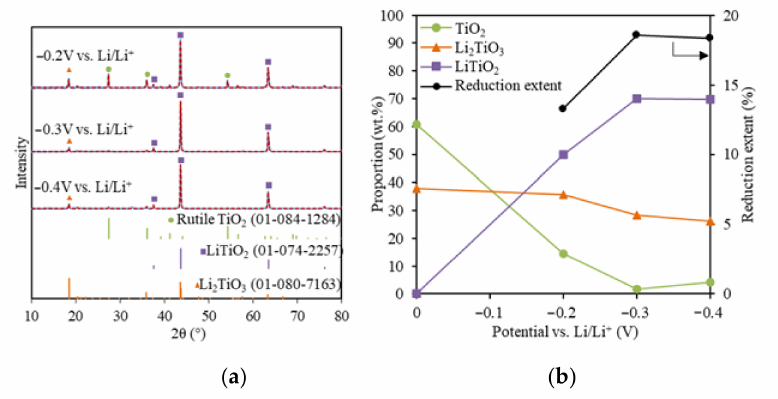
Figure 2. ( a ) XRD results (blue solid lines) and Rietveld refinement analysis (red dash lines) of the reduced TiO 2 samples at − 0.2 V, − 0.3 V, and − 0.4 V vs. Li/Li + with 80% of the theoretical charge; ( b ) reduced sample compositions and reduction extents for the TiO 2 reductions at − 0.2 V, − 0.3 V, and − 0.4 V vs. Li/Li +